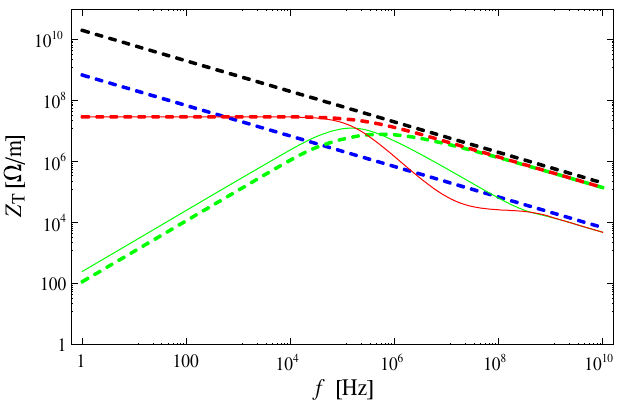
FIG. 6. Transverse coupling impedance of the 1 m long LHC coated graphite collimator, coated with a 5 (cid:2) m copper layer of (cid:4) 6 (cid:1) 10 7 = (cid:3) m conductivity (see Fig. 5). The real and imagi- nary impedance of the coated (uncoated) tube is shown by solid (dashed) green and red curves. Also shown are the absolute values of the impedances in the classic thick wall approximation for an unbound graphite (black) and copper (blue)